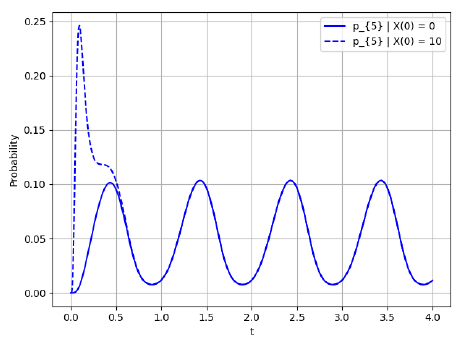
Figure 13. Probability p 5 ( t ) for t ∈ [ 0,4 ] ; this figure shows the rate of convergence for N = 10.